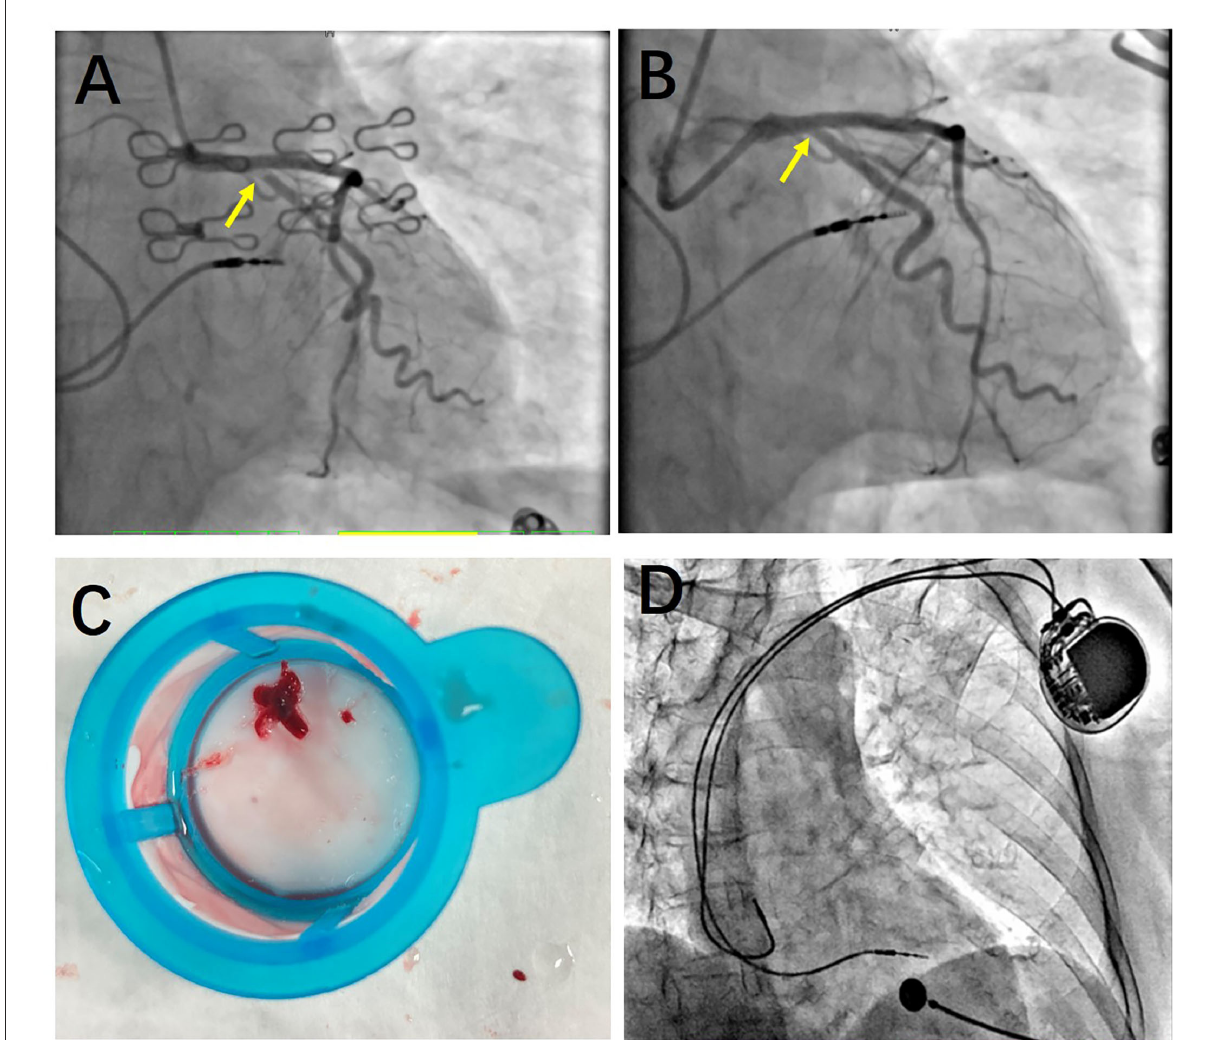
FIGURE2 Coronary angiography. (A) Before thrombus aspiration, a large filling defect remained due to an extensive thrombus in the proximal left circumflex (LCX) with The Thrombolysis In Myocardial Infarction (TIMI) grade 2 flow. (B) After thrombus aspiration, the large filling defect appeared. And the TIMI grade of LCX improved. (C) A large thrombus was presented after thrombus aspiration. (D) Atrial and ventricular leads of dual-chamber pacemaker were normal. No leads’ dislodgement or fracture was found.